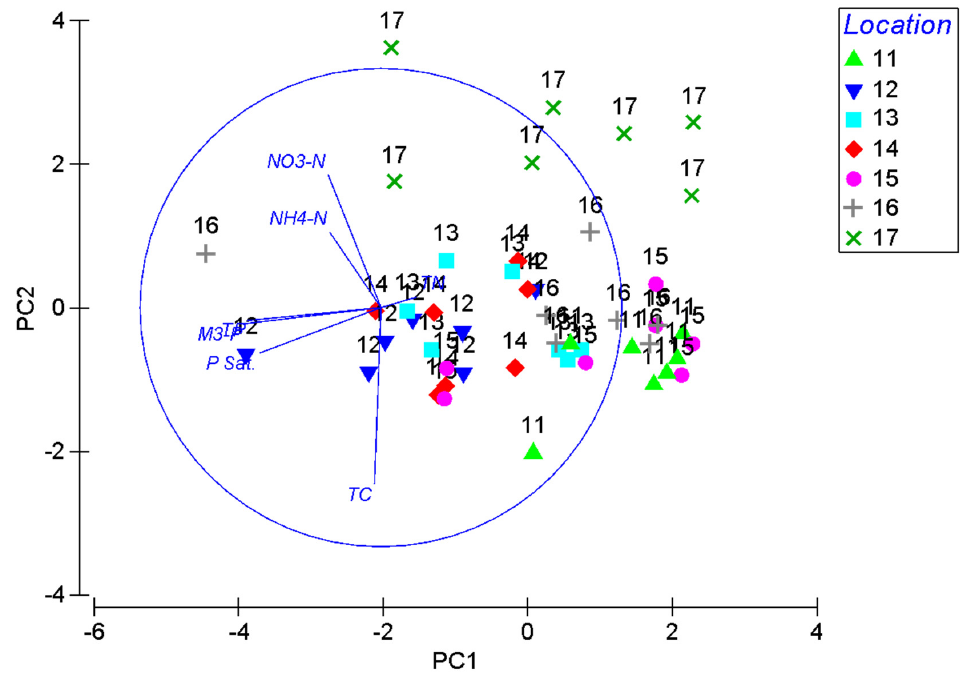
Figure 7. PCA plot for Site II soil